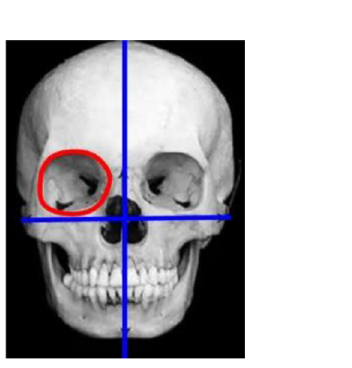
Fig. 1. Components of this study.